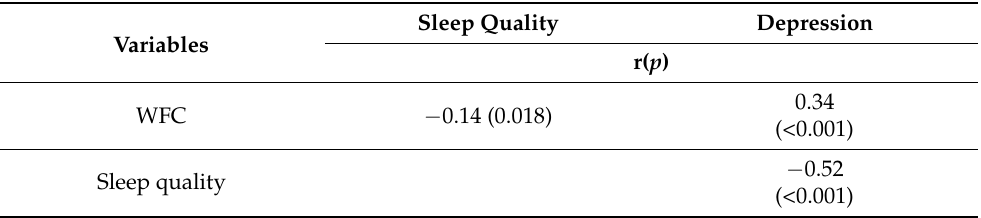
Table 6. Correlations among WFC, sleep quality, and depression ( n =